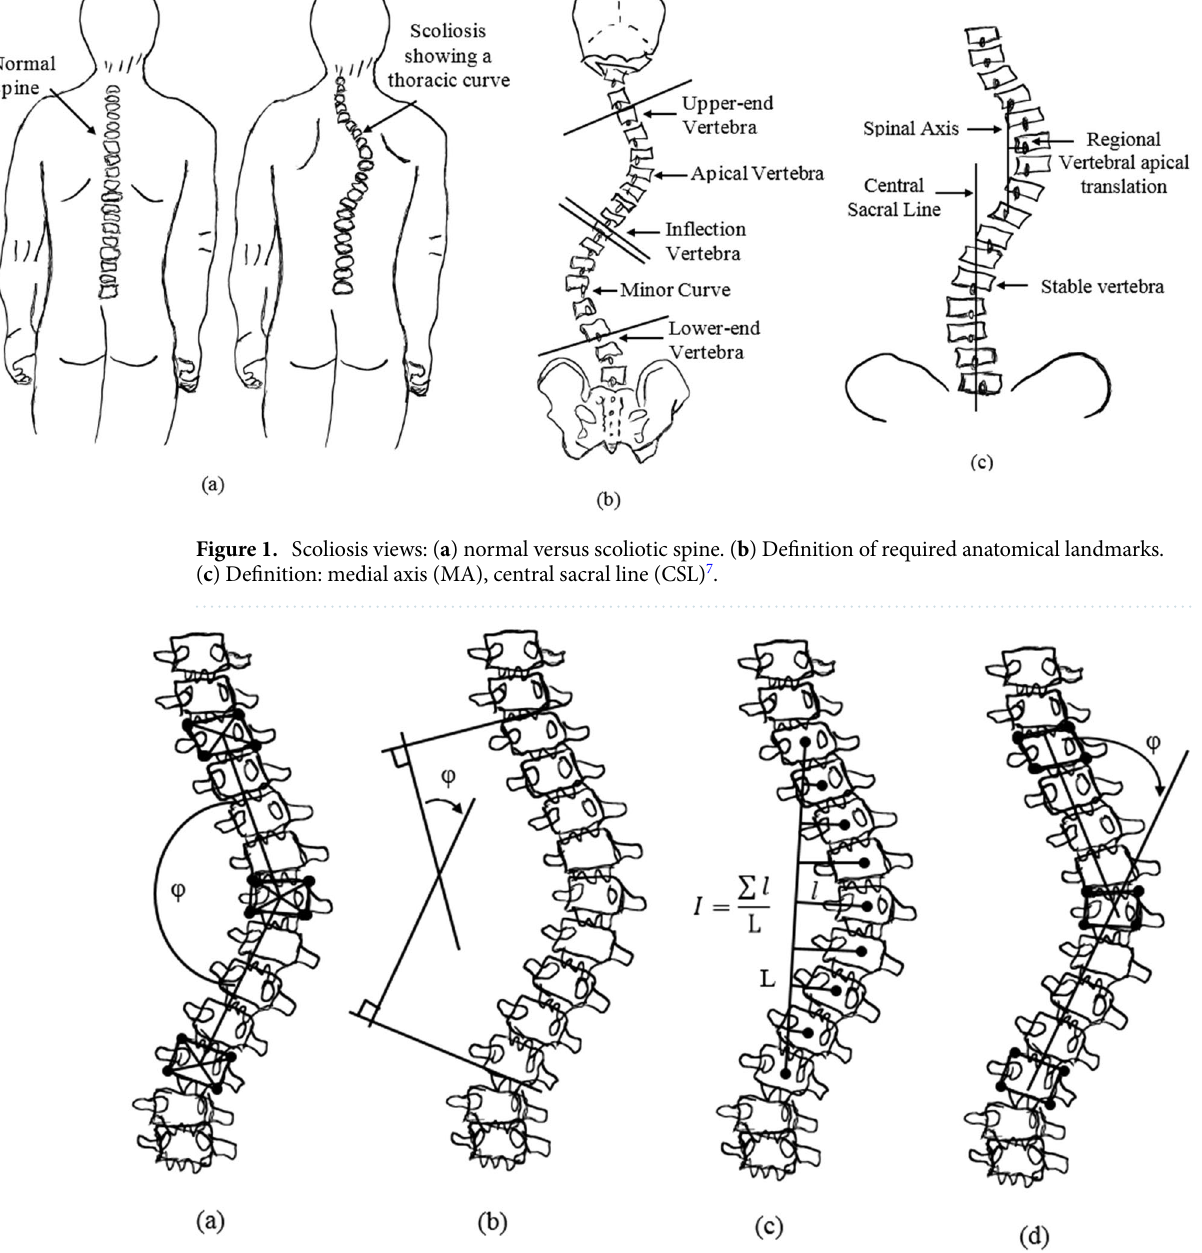
Figure 2. Spinal curvature evaluation ( a ) Ferguson, ( b ) Cobb, ( c ) Greenspan Index and ( d ) Diab method 8